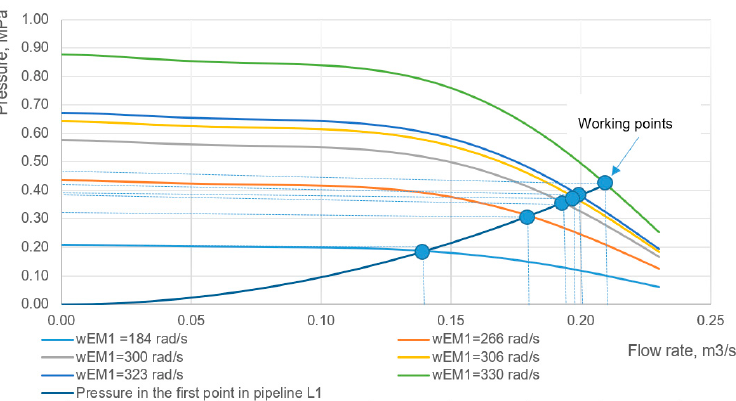
Figure 17. Curves at various angular velocities for the main pump (SMR pump Model SMR 200; see Figure 8) as a component of the presented model.